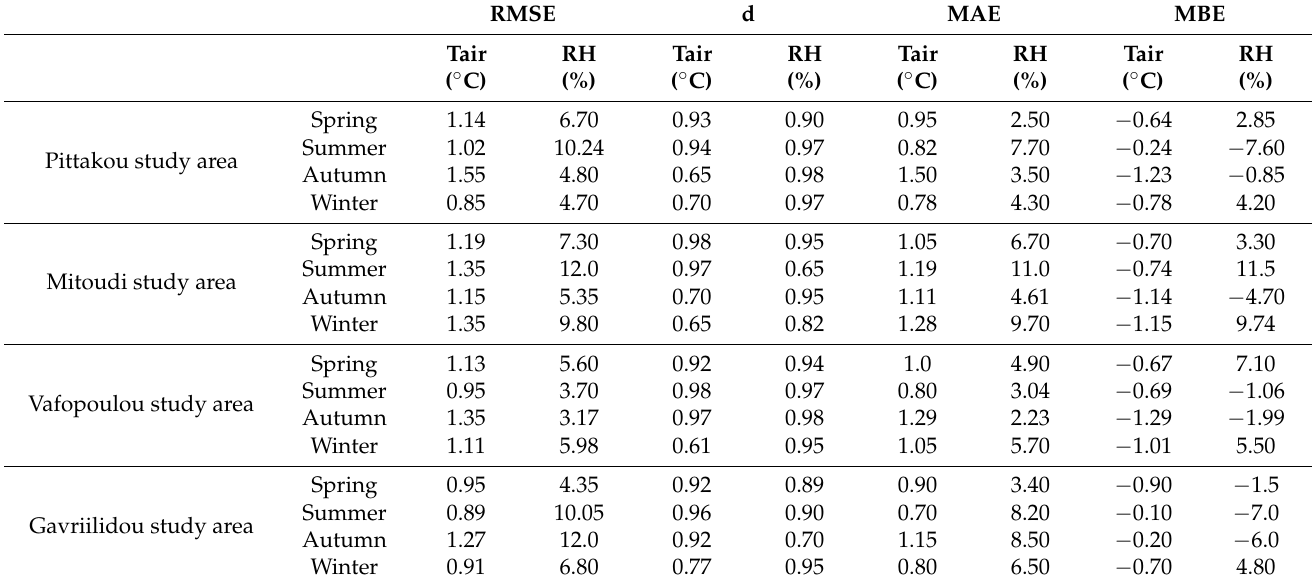
Table 6. Estimated difference metrics for all case study areas and for all